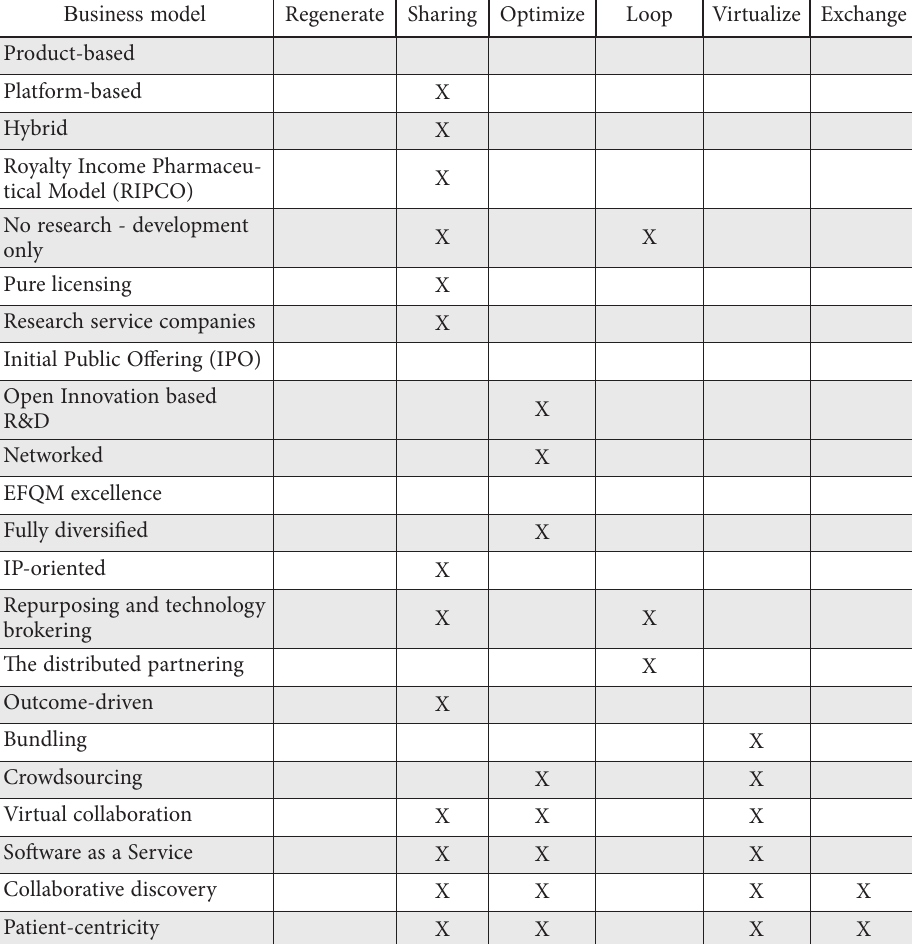
Table 5. The evaluation of circularity criteria in biotechnology business